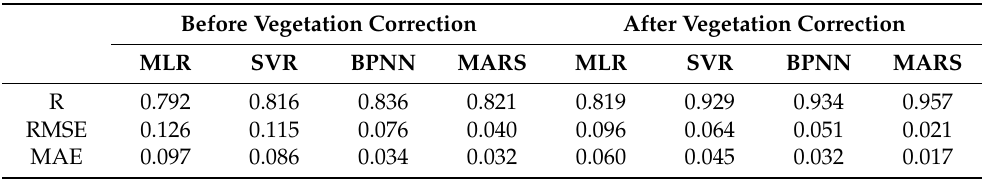
Table 2. Statistics of the SMC estimation accuracy of each model. Before Vegetation